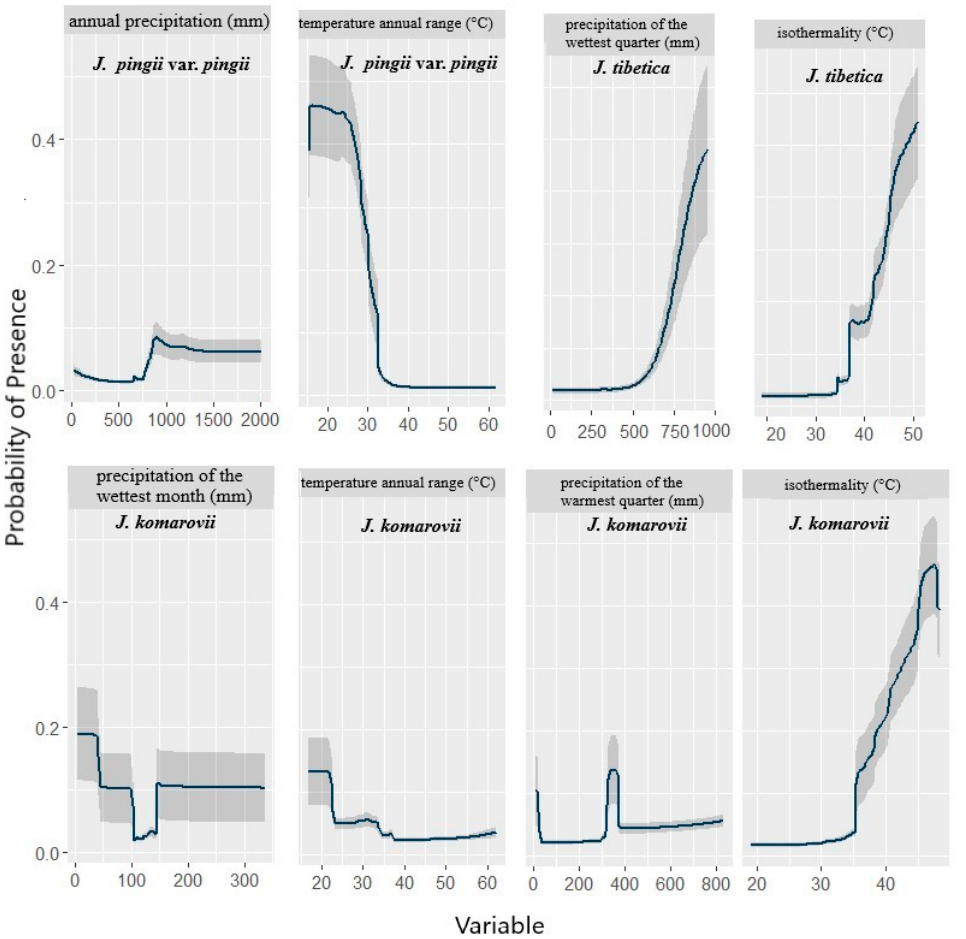
Figure 1. Response curves of the most important predictor variables used in distribution modelling of Juniperus species.